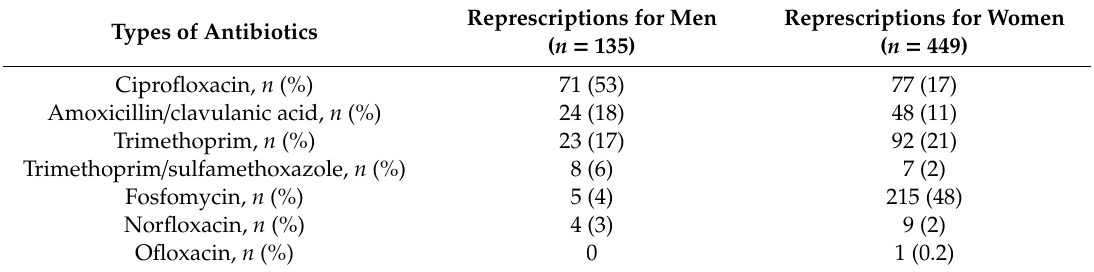
Table 2. Distribution prescribed antibiotics within 30 days after first nitrofurantoin prescription in